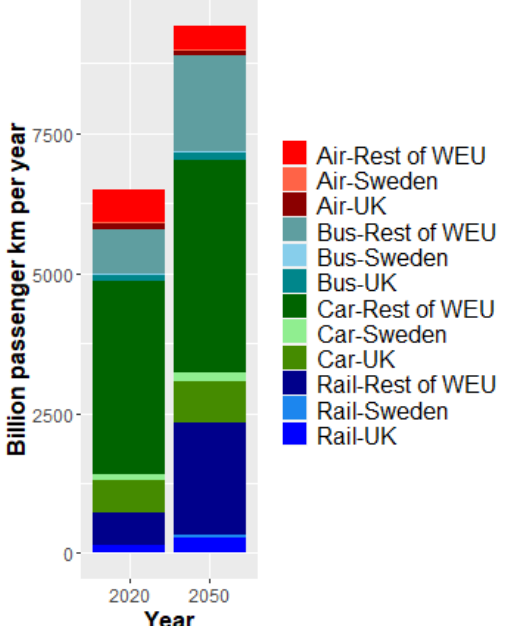
Figure 4. Downscaling mobility from WEU to the UK and Sweden. The total distances travelled for the Western Europe (WEU) region from the ‘1.5C Total’ scenario [16] are downscaled to the UK and Sweden using ratios derived from a detailed scenario [67].